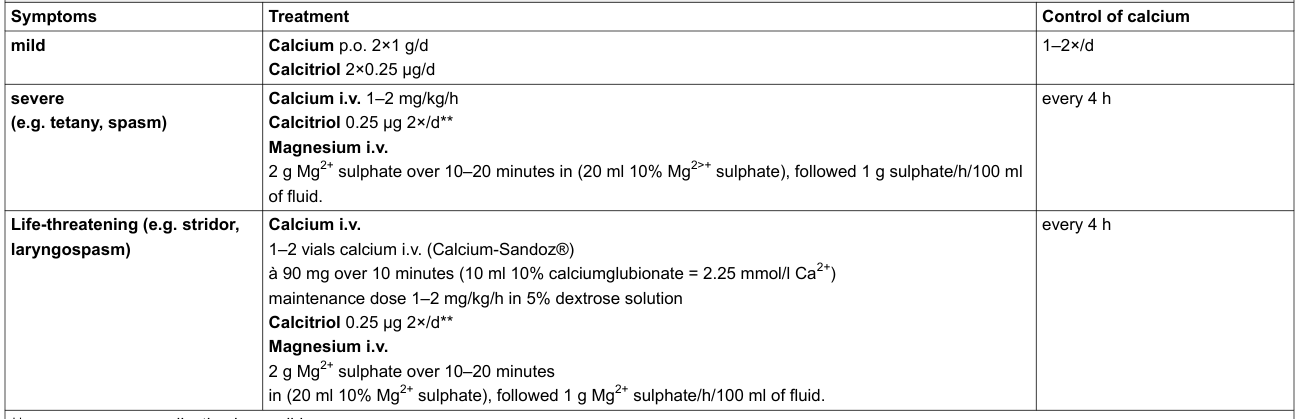
Table 2: Emergency treatment of hypocalcemia (calcium ionized <0.8 mmol/l), albumin-corrected plasma calcium <2.0 mmol/l). Symptoms